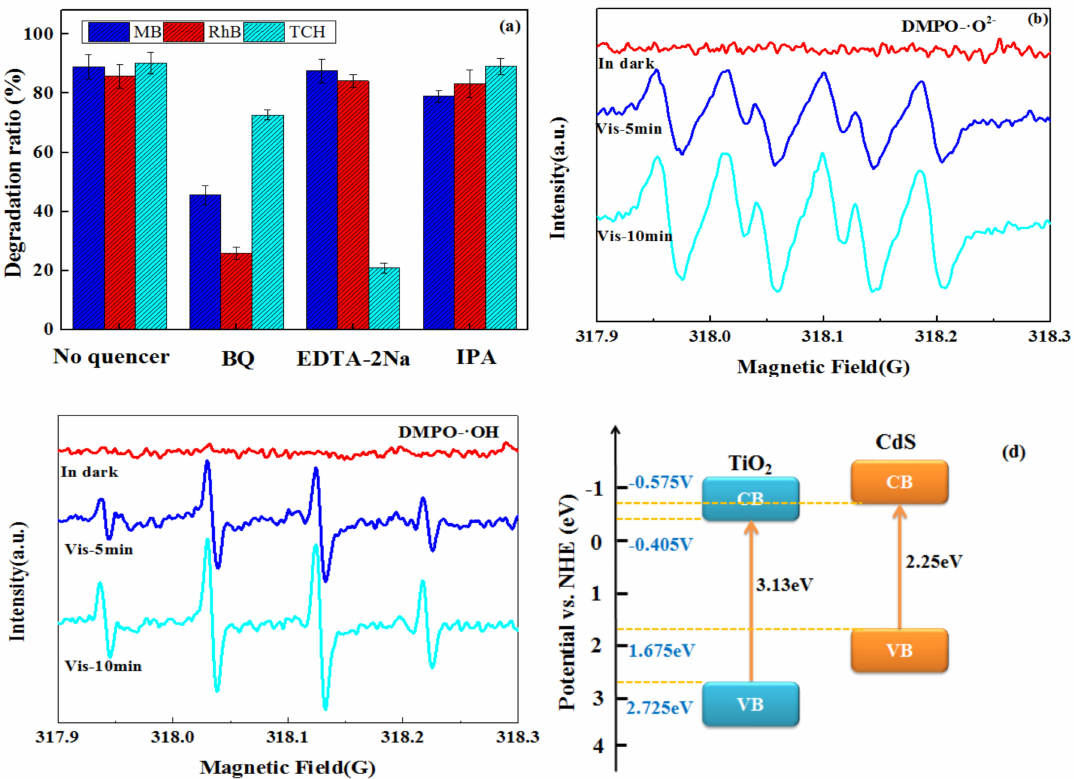
Figure 6. Reactive species trapping experiments of 0.10CdS@TiO 2 under visible light irradiation ( a ); ESR spectra of radicals trapped by DMPO in the presence of 0.10CdS@TiO 2 samples in the dark and under visible light irradiation: DMPO– • O 2 − ( b ), DMPO– • OH ( c ); the calculation of the CB and VB potentials of CdS and TiO 2 ( d